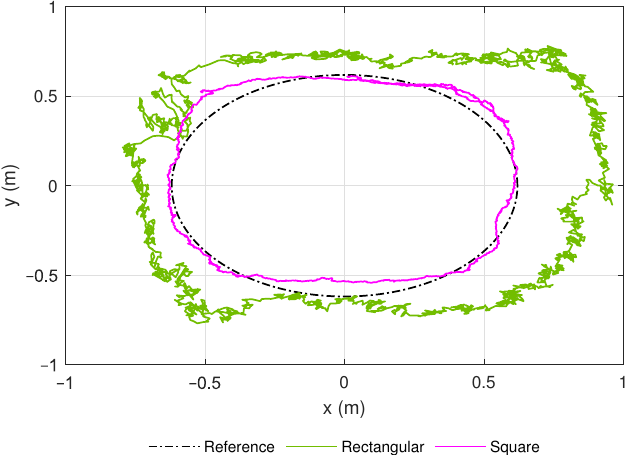
Figure 9. Performance of anchors in rectangular (green) and square (pink) configuration concerning a reference